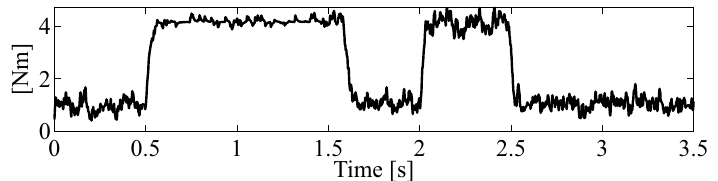
Figure 11. Load torque applied in the dynamic model parameter variation tests.